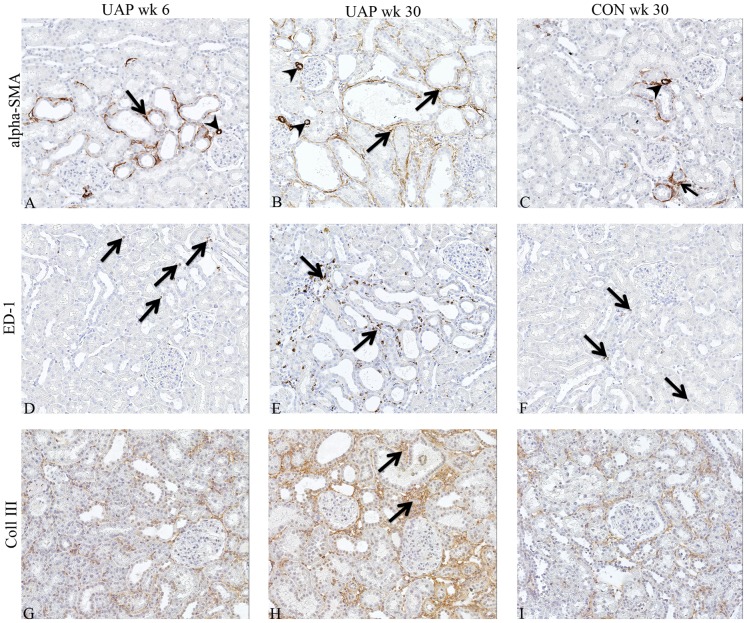
Representative photographs of renal damage markers in adriamycin-exposed and control kidneys.Interstitial α-SMA increased progressively in proteinuric kidneys during follow up (A, B). α-SMA was located around dilated tubules (arrows) and in blood vessels (arrowheads). In control kidneys at week 30, only very limited expression of interstitial α-SMA was present (C). Interstitial macrophage influx increased in ADR animals (D, E). ED-1 positive cells were found mostly around damaged tubules (arrows) and sporadically present in the interstitium of control kidneys (F). Immunostaining of collagen III was found in ADR animals (G, H; arrows), and rarely in controls (I).